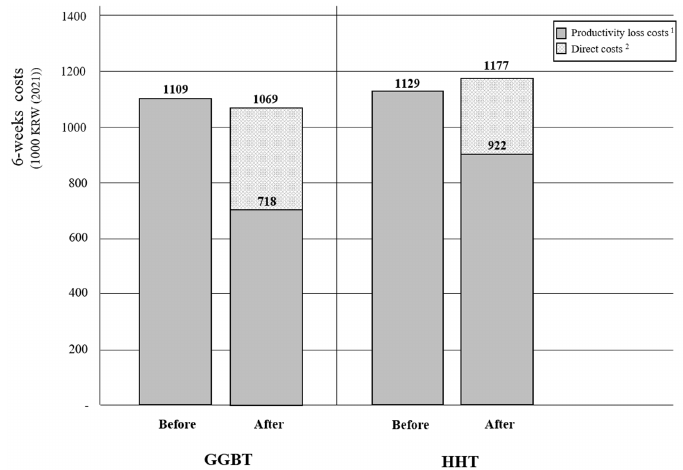
Figure 2. Comparison of 6 weeks per patient (1000 KRW (2021)) before and after initiating treatment. Abbreviations: GGBT, Gamiguibi ‐ tang; HHT, Hwangryunhaedok ‐ tang. 1 Productivity loss costs include costs for both work productivity loss and daily activity impairment. 2 Direct costs associated with traditional Korean treatment include direct medical and non ‐ medical costs.